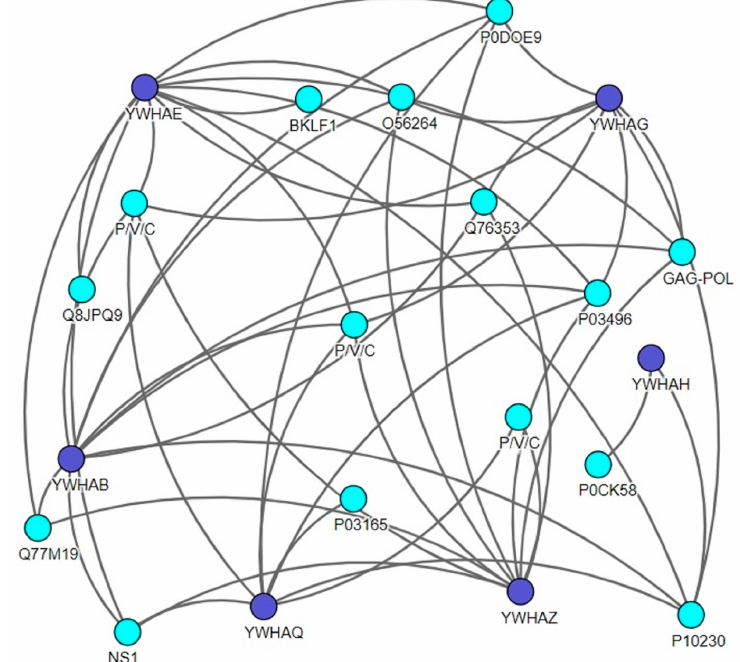
Figure 1. The Virusmentha network showing a host (14-3-3s)–virus interaction map. Lines between the proteins indicate interactions between proteins. Purple nodes indicate the di ff erent 14-3-3 isoforms, and blue nodes indicate the viral proteins. The Virusmentha database is available at https: // virusmentha. uniroma2.it /